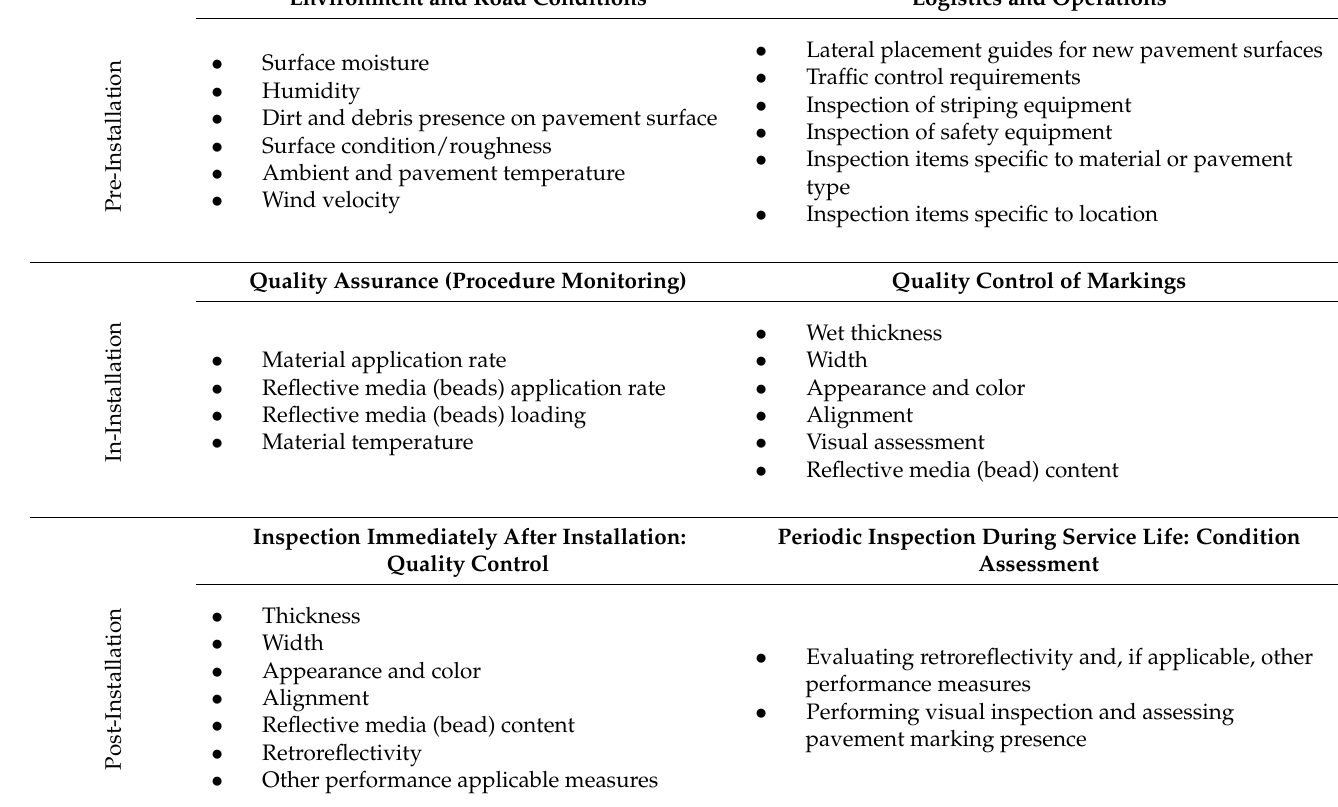
Table 3. Inspection items for pavement marking installation and